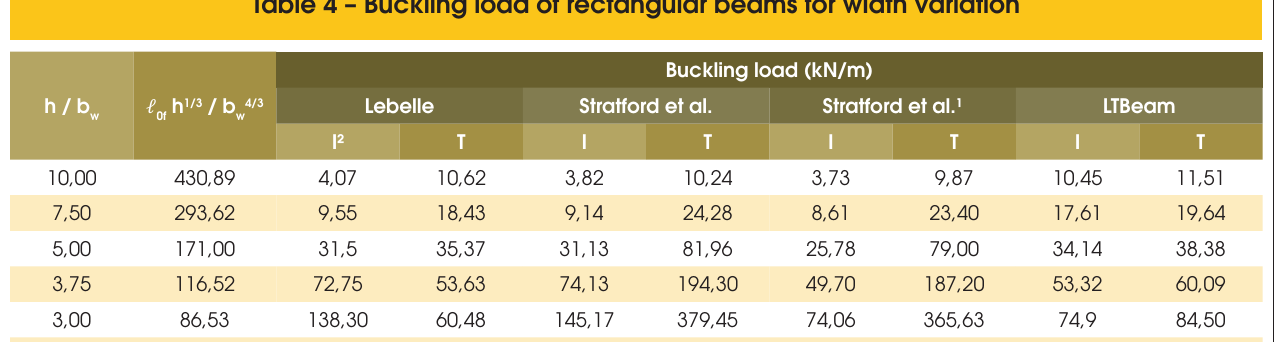
Table 4 – Buckling load of rectangular beams for width